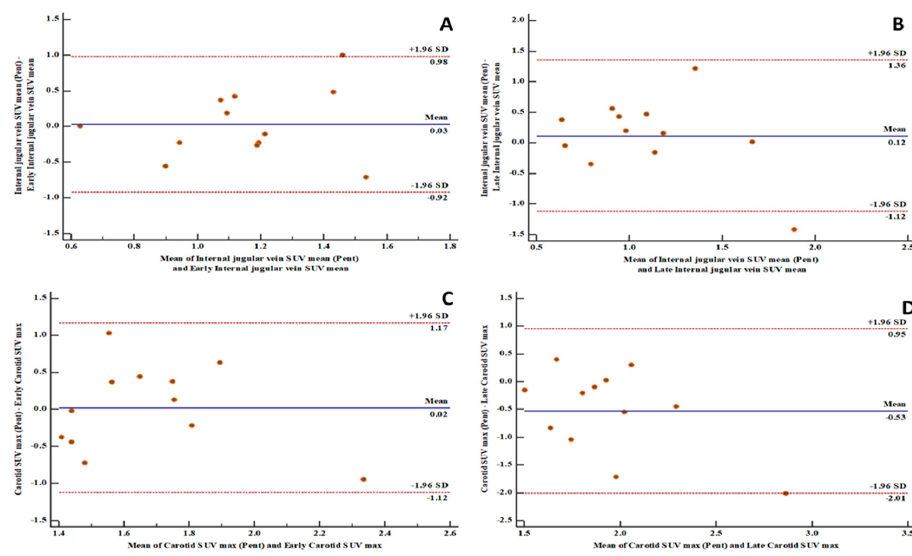
Figure 2. Bland and Altman plots showing good levels of agreement between [ 18 F]FDG PET / CT and [ 68 Ga]Ga-pentixafor PET / CT-derived variables: ( A ) a good level of agreement between [ 68 Ga]Ga-pentixafor PET-derived internal jugular vein SUVmean and [ 18 F]FDG PET-derived early internal jugular vein SUVmean with 91.7% of measurements within the limits of agreement; ( B ) a good level of agreement between [ 68 Ga]Ga-pentixafor PET-derived internal jugular vein SUVmean and [ 18 F]FDG PET-derived late internal jugular vein SUVmean with 91.7% of measurements within the limits of agreement; ( C ) a good level of agreement between [ 68 Ga]Ga-pentixafor PET-derived carotid SUVmax and [ 18 F]FDG PET-derived early carotid SUVmax with 100% of measurements within the limits of agreement; ( D ) a good level of agreement between [ 68 Ga]Ga-pentixafor PET-derived carotid SUVmax and [ 18 F]FDG PET-derived late carotid SUVmax with 91.7% of measurements within the limits of agreement. SD: standard deviation.